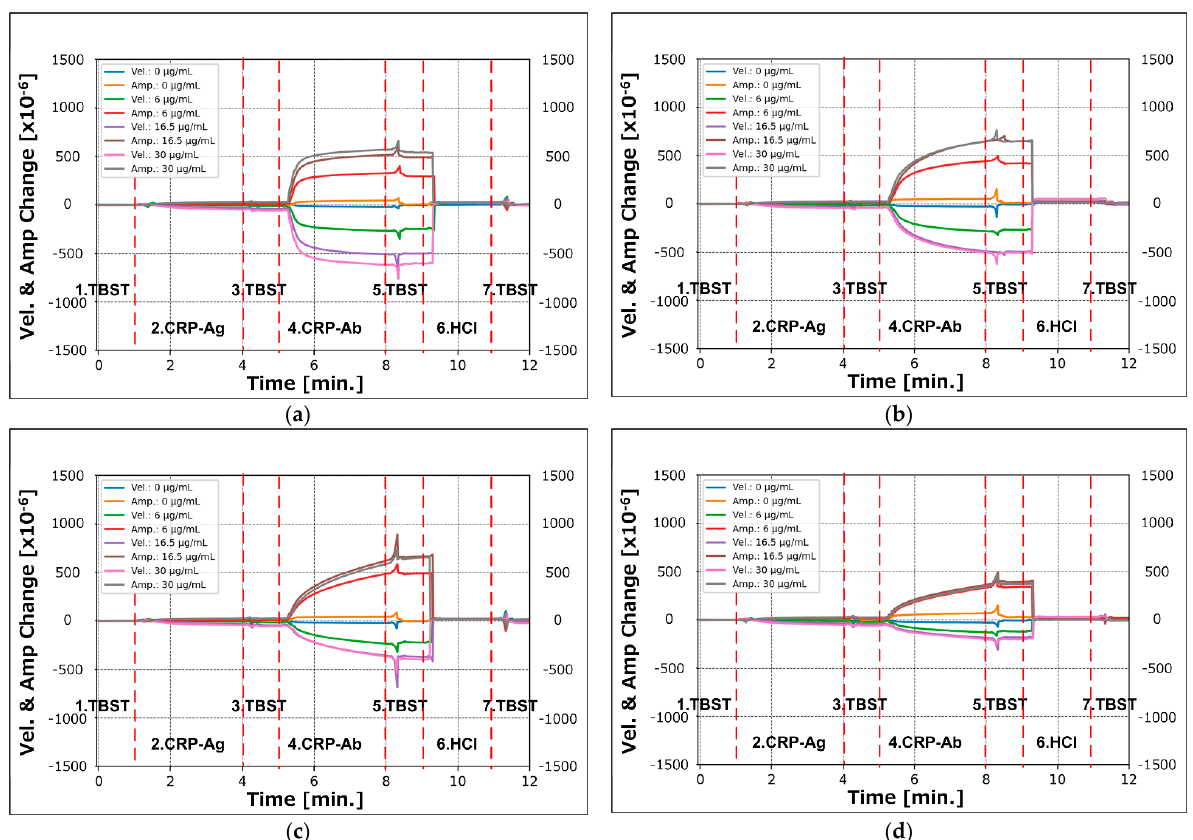
Figure 7. Recorded time-course response of velocity and amplitude changes in the SH-SAW for the CRP assay process. Secondary antibodies conjugated with gold nanoparticles of diameters of ( a ) 10 nm; ( b ) 15 nm; ( c ) 20 nm; ( d ) 30 nm.